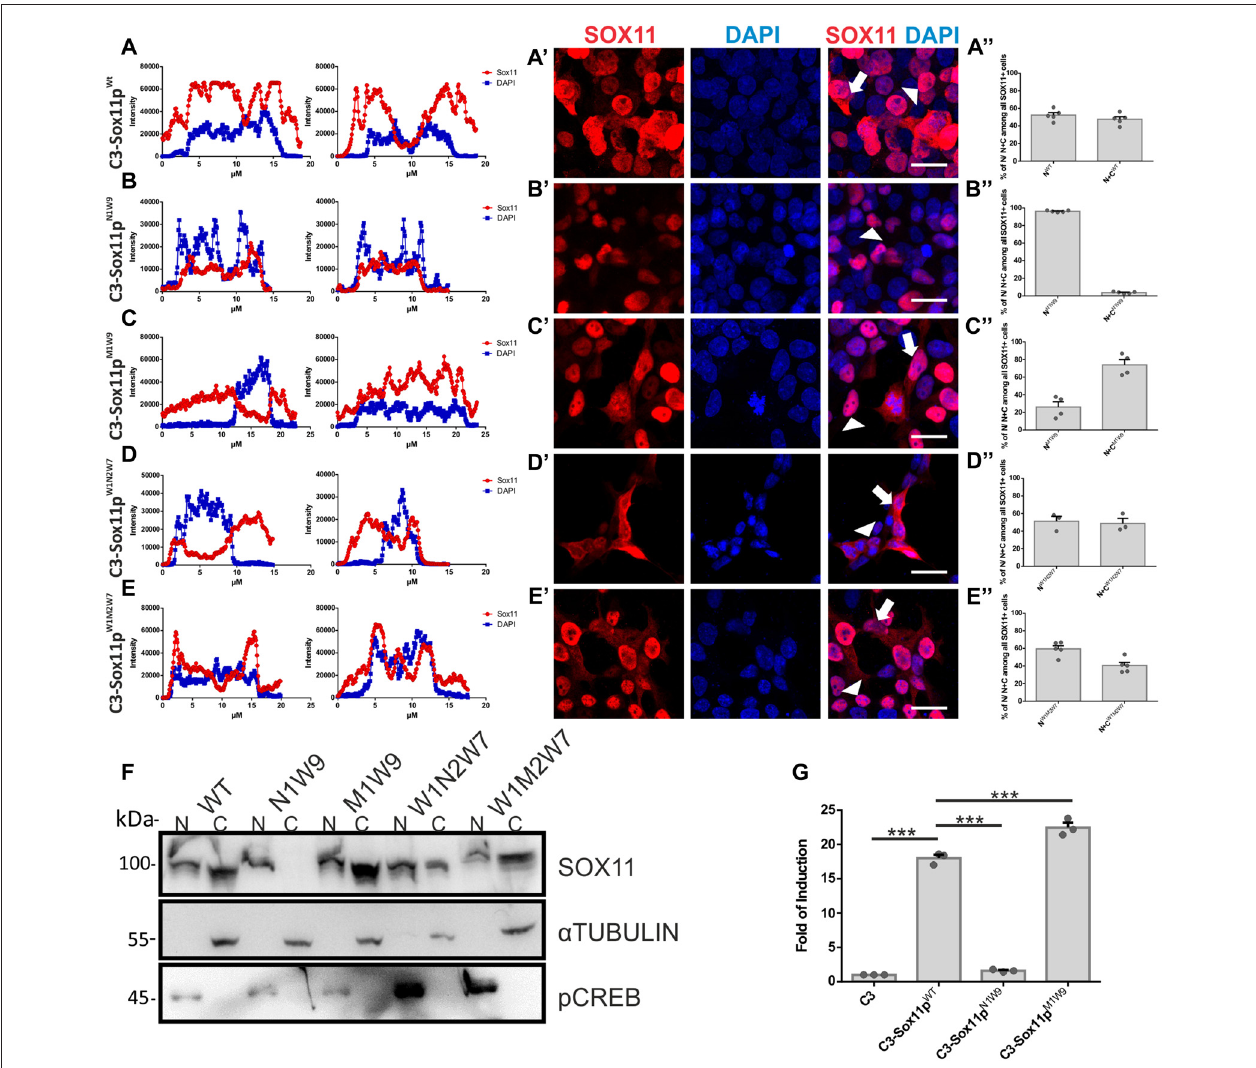
FIGURE 6 | SOX11’s subcellular localization depends on the phosphorylation of S30. (A–E) Representative line intensity plots of HEK293T cells transfected with SOX11 WT and mutants. The blue line represents DAPI intensity, the red line represents SOX11 intensity. (A’–E’) Immunostaining for SOX11 (red) and DAPI (blue) of cells transfected with SOX11 WT and mutants were to determine the subcellular localization of SOX11 phospho-mutants. Note that the C3-Sox11p N1W9 is almost exclusively localized in the nucleus (B’) . Arrow: cell with nuclear and cytoplasmic localization of SOX11. Arrow head: cell with only nuclear localization of SOX11. Scale bars: 20 µ m. (A (cid:48)(cid:48) –E (cid:48)(cid:48) ) Percentage of cells with nuclear localization (N) or nuclear and cytoplasmic (N + C) localization of the different SOX11 mutants. (F) Western Blot analysis of nuclear (N) and cytoplasmic (C) extracts of Neuro2a cells overexpressing C3-Sox11p Wt (WT), C3-Sox11p N1W9 (N1W9), C3-Sox11p M1W9 (M1W9), C3-Sox11p W1N2W7 (W1N2W7) and C3-Sox11p W1M2W7 (W1M2W7). First row: blotting with an anti-SOX11 antibody; Second row: Blotting with an anti-pCREB (S133) antibody validates enrichment of nuclear proteins; third row: Blotting with an anti- α TUBULIN validates enrichment of cytoplasmic proteins. Note that the N1W9 mutant is exclusively detected in the nuclear fraction. (G) Activity of a luciferase reporter driven by a minimal SOX11 responsive promoter in HEK293T cells overexpressing C3 (empty backbone), C3-Sox11p Wt , C3-Sox11p N1W9 and C3-Sox11p M1W9 , n = 3 ( ∗∗∗ p < 0.001).